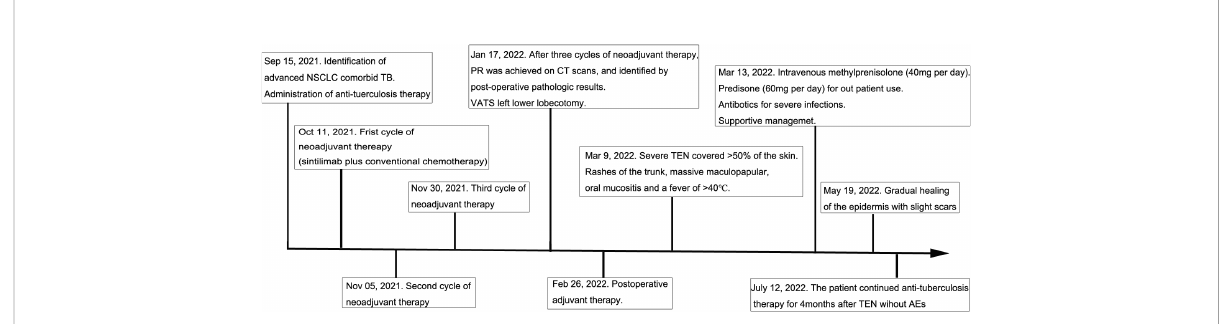
FIGURE 3 Anti-tuberculosis therapy: Isoniazid (300 mg per day), Rifampicin (450 mg per day), Ethambutol (750 mg per day), Pyrazinamide (1250 mg per day). Neoadjuvant therapy: Sintilimab (200 mg) plus platinum-based conventional chemotherapy (paclitaxel and cisplatin). PR, Partial response; TEN, Toxic epidermal necrolysis; AE, Adverse